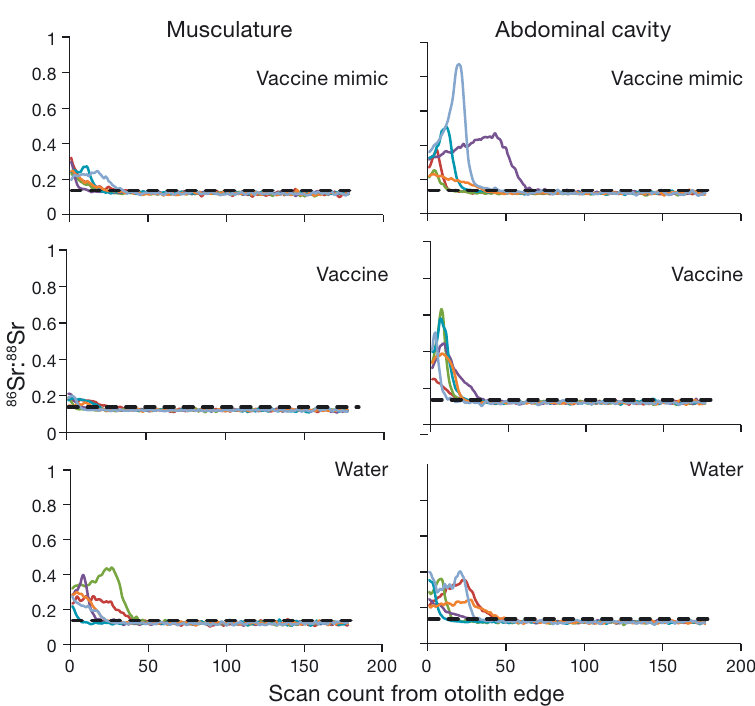
Fig. 2. Salmo salar. Mark success with 86 Sr: 88 Sr for the 6 enrichment treatments. Details as in Fig. 1